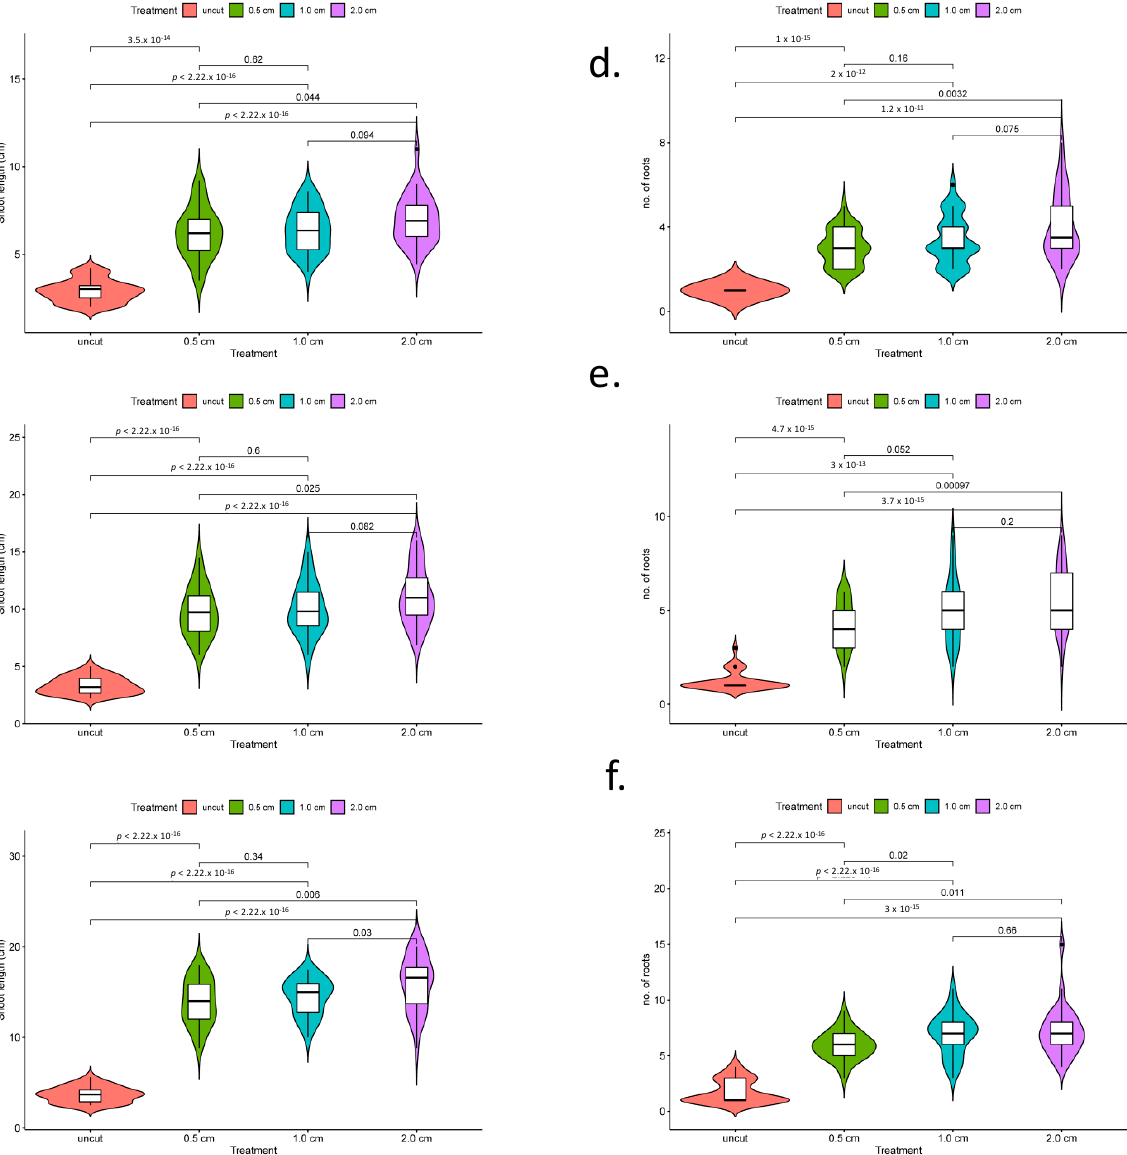
Figure 2. Comparisons of the shoot lengths and number of lateral roots in samples with different root excision patterns and controls (uncut) at three timepoints. Violin plot, box plots of shoot length at one month ( a ), two months ( b ), and three months after root cutting ( c ). Violin plot, box plots of the number of lateral roots at three timepoints, one month ( d ), two months ( e ), and three months ( f ) after root excision.